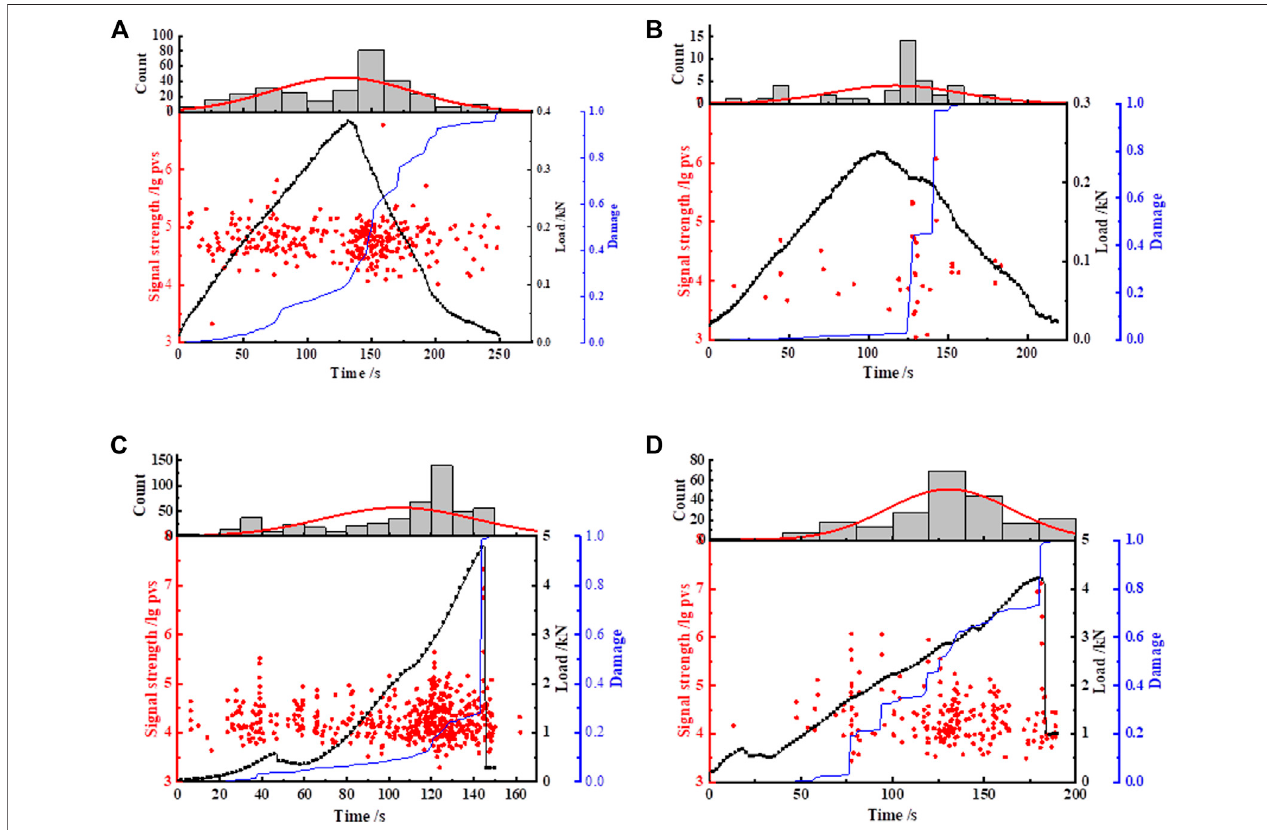
FIGURE 7 | Distribution of load, damage and signal strength for typical sandstone with different grain sizes under Brazilian splitting (A) medium sandstone, (B) coarse sandstone, (C) siltstone, and (D) fi ne sandstone.